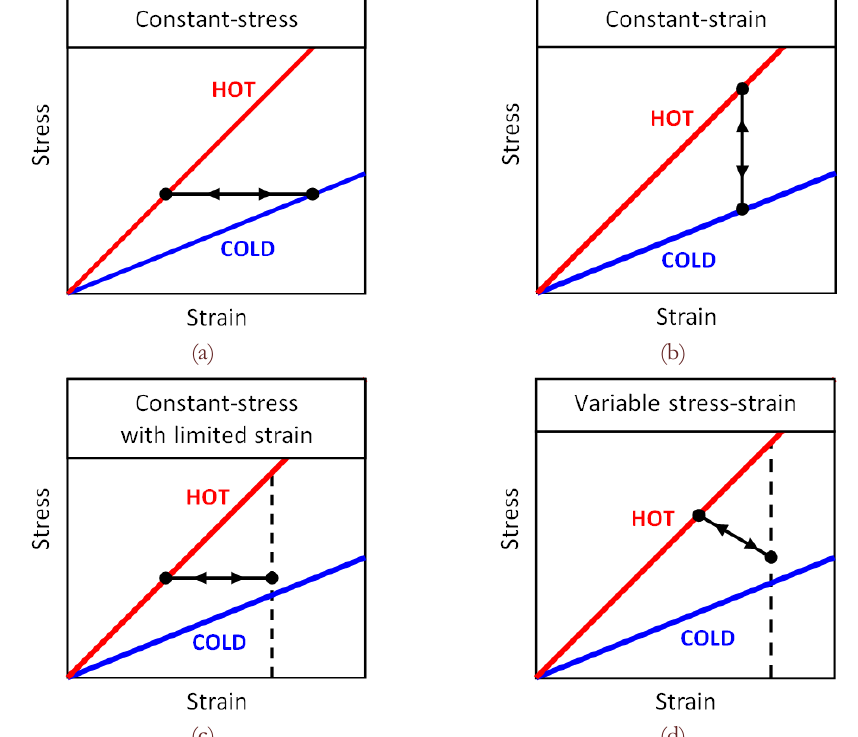
Figure 1: Specific tests proposed to characterize the SMA wires under functional fatigue: a) constant-stress; b) constant-strain; c) constant-stress with limited maximum strain; d) linear stress-strain